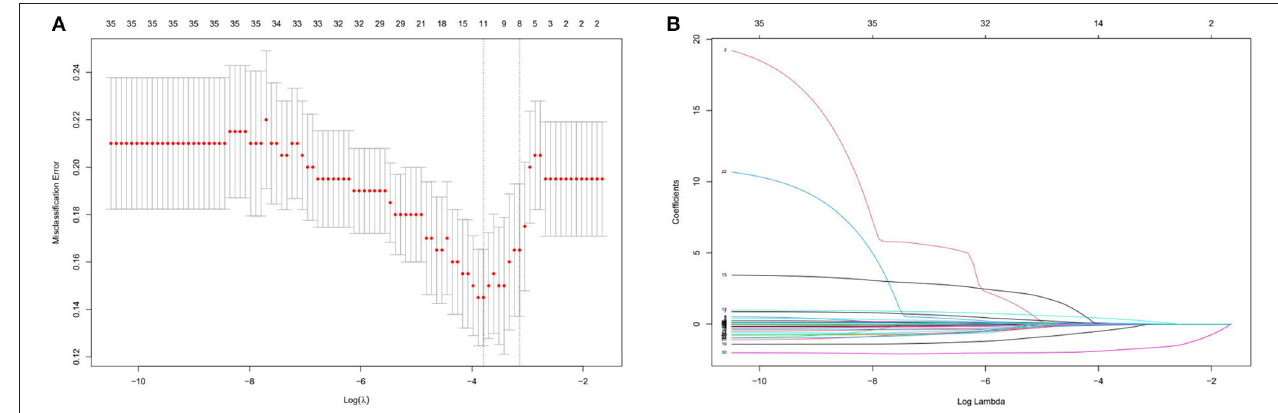
FIGURE 3 | This figure shows the results of a one-time randomized screening by least absolute shrinkage and selection operator (Lasso) regression. (A) Variation of misclassification error. The horizontal axis shows log λ and the vertical axis shows the misclassification error. The numbers above the curve represent the number of feature of nonzero coefficient. The left dotted line represents the feature number corresponding to 0 standart error of misclassification. (B) The shrinkage plot of coefficients. The horizontal axis shows log λ and the vertical axis shows coefficient. The numbers above the curve represent number of features with